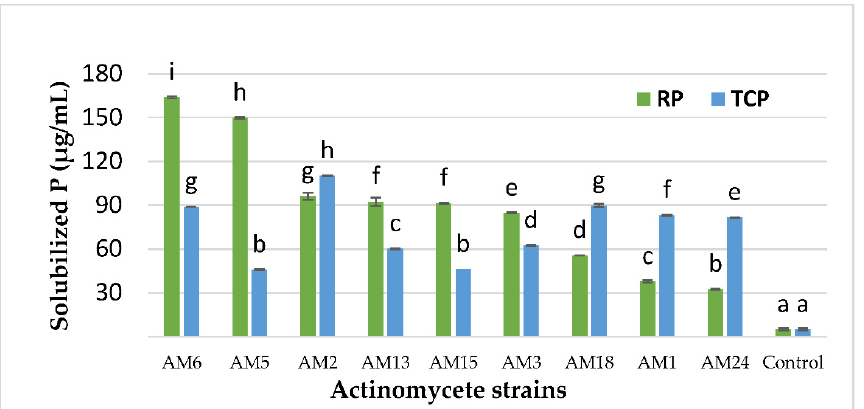
Figure 2. Concentration of soluble phosphate released (µg/mL) from tricalcium phosphate (TCP) and natural rock phosphate (RP) in the non-inoculated flasks (control) and in the supernatant cultures of the eight selected actinomycete isolates grown for five days in SMM containing 0.5 g/L RP or 0.5 g/L TCP. Error bars represent standard deviations of the mean values of the results of three independent culture replicates. Different lowercase letters above bars indicate significant differences between treatments at p ≤ 0.05.